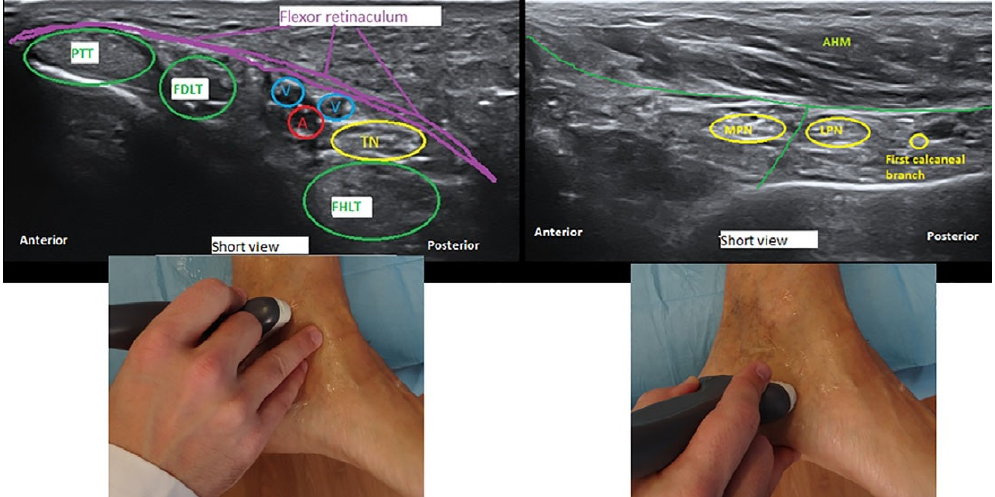
Figure 1. Ultrasound delineation of the anatomy of the tarsal tunnel: transverse or short-axis view (cross section) at the proximal and distal tarsal tunnel. A indicates posterior tibial artery; FDLT, flexor digitorum longus tendon; FHLT, flexor hallucis longus ten don; PTT, posterior tibial tendon; AHM, abductor hallucis muscle; V, posterior tibial vein; TN, tibial nerve; MPN, medial tibial nerve; and LPN, lateral plantar nerve.